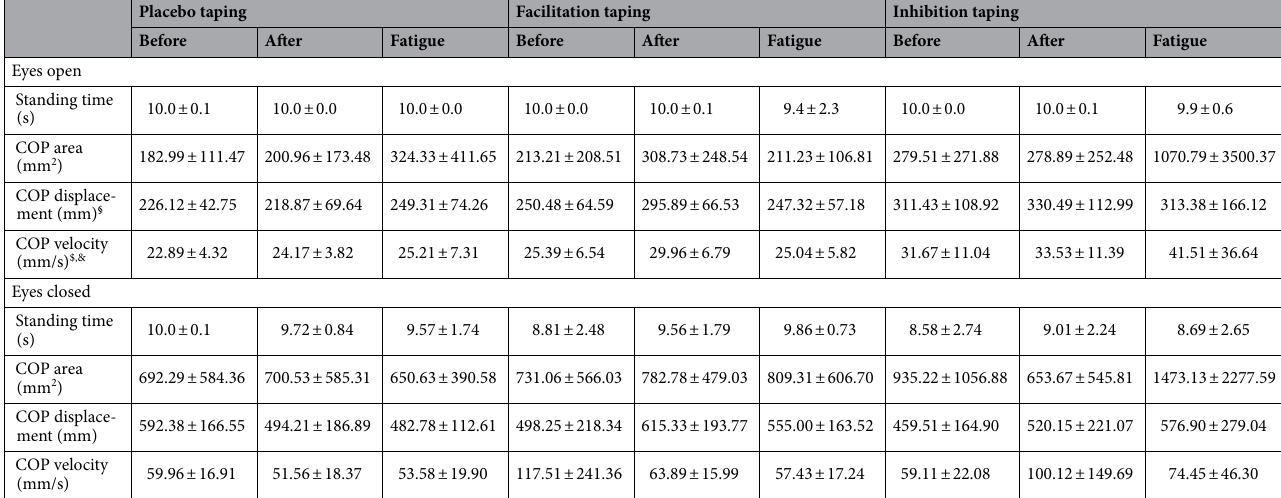
Within-subject (pre-post-post